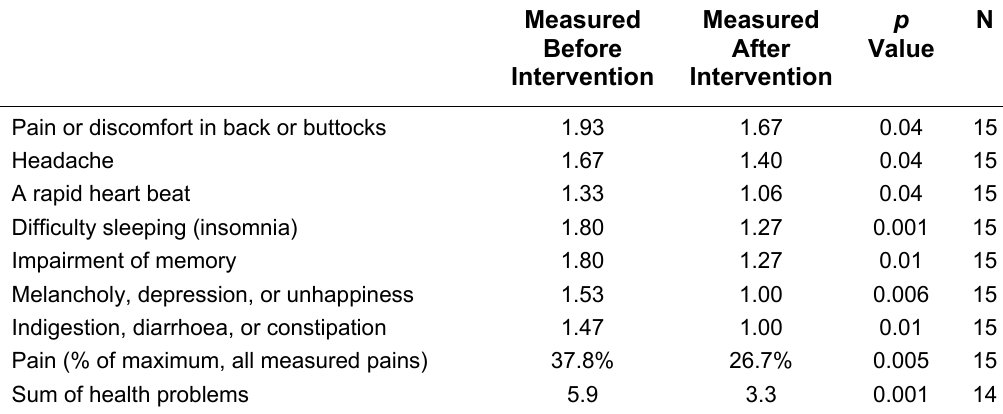
Health Problems, Relieved by the 5-Day QOL Intervention, Measured by the SEQOL